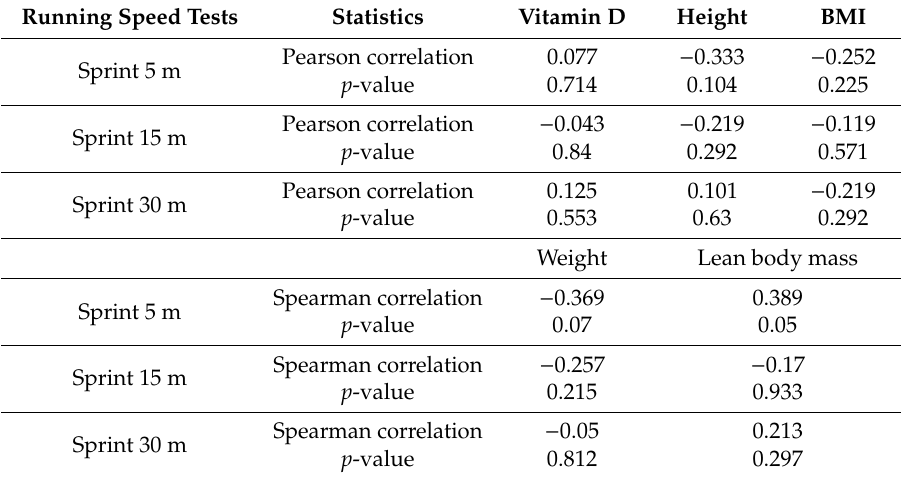
Table 5. Correlations between the change in sprint performance and change in vitamin D and correlations between the change in sprint performance and change in anthropometrics before and after